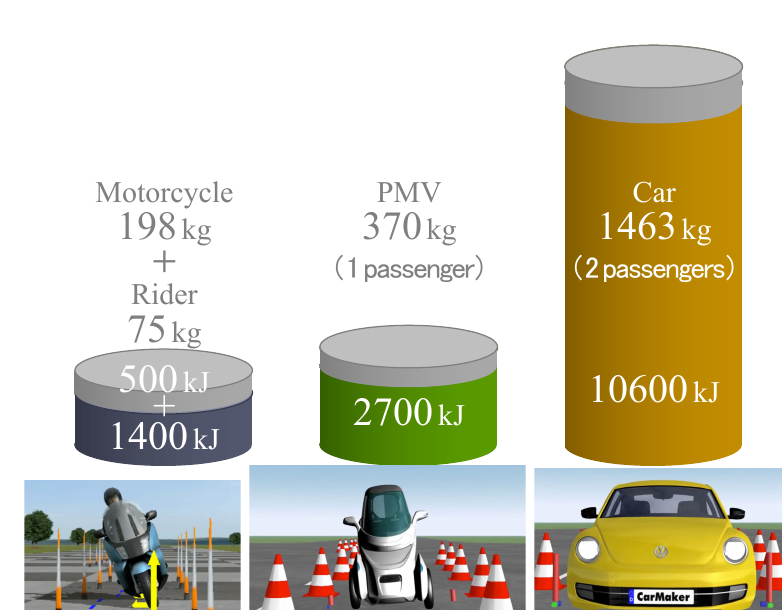
Figure 38. Comparison of energy consumption of general vehicles on rolling